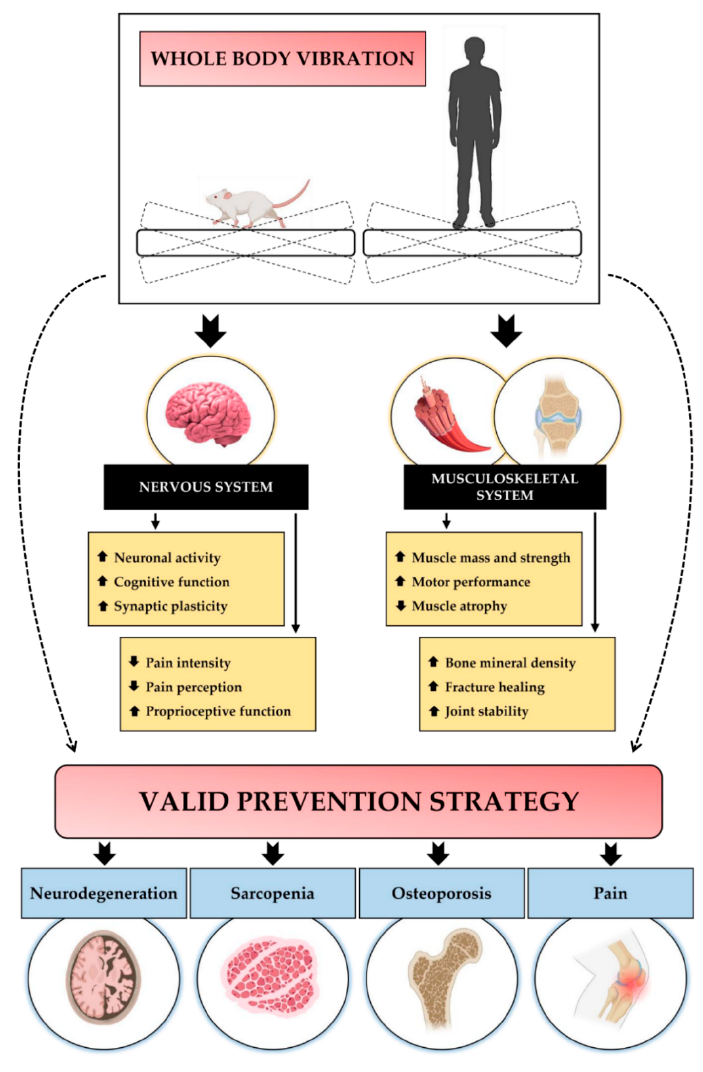
Figure 1. A schematic representation of the WBV effects on the nervous and musculoskeletal systems. WBV improves brain health by increasing neuronal activity, cognitive function, and synaptic plasticity. At the nervous system level, WBV also promotes proprioceptive function, reducing the intensity and perception of pain. At the level of the musculoskeletal system, WBV increases muscle mass and strength, as well as motor performance, while reducing muscle atrophy. In addition, vi- bratory training increases bone mineral density and promotes fracture healing and joint stability. Taken together, these effects make WBV a valuable preventive strategy for neurodegenerative dis- eases, musculoskeletal disorders such as sarcopenia and osteoporosis, and pain-associated diseases. 3.1. WBV Improves Cognitive Function and Counteracts Neurodegeneration The transmission of vibrations and oscillations to the body is known to stimulate skin receptors, muscle spindles and the vestibular system, inducing numerous changes in brain activity, such as those in the somatosensory cortex, thalamus, hippocampus, and